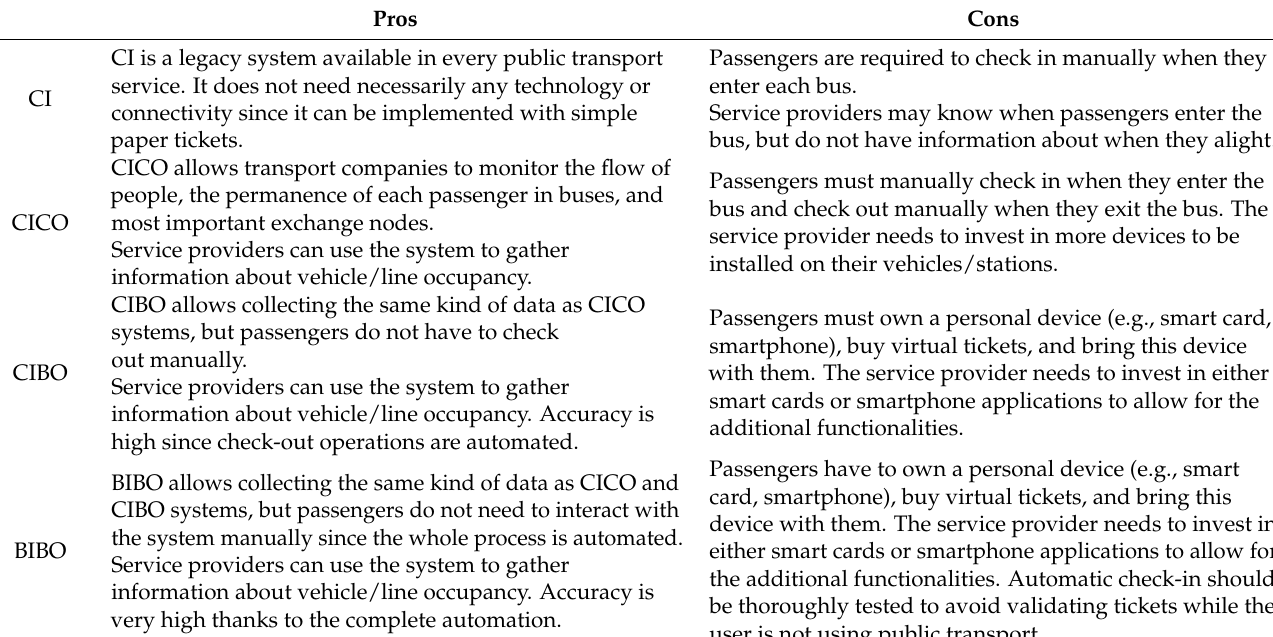
Table 1. System setting variables used during the